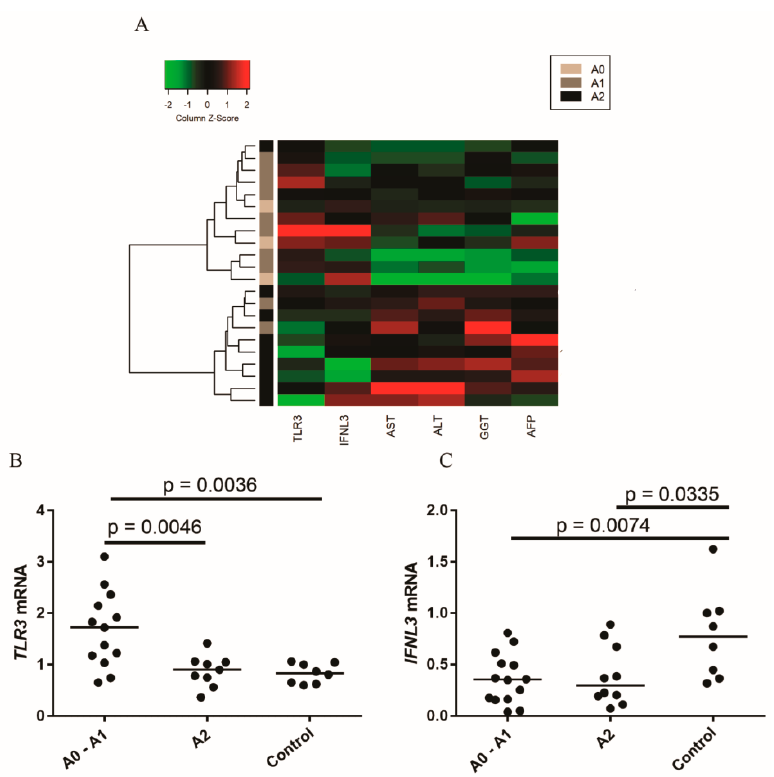
Figure 3. ( A ) Heatmap of the intrahepatic gene expressions of TLR3 and IFNL3 and the levels of biochemical markers (AST, ALT, GGT and AFP) relative to the liver necroinflammatory activity in patients. Comparison of the expression levels of ( B ) TLR3 and ( C ) IFNL3 among patients with different degrees of necroinflammatory activity and the control group. Mean TLR3 : A0-A1 = 1.8, A2 = 0.84 and control = 0.81; mean IFNL3 : A0-A1 = 0.47, A2 = 0.44 and control = 0.85. ANOVA